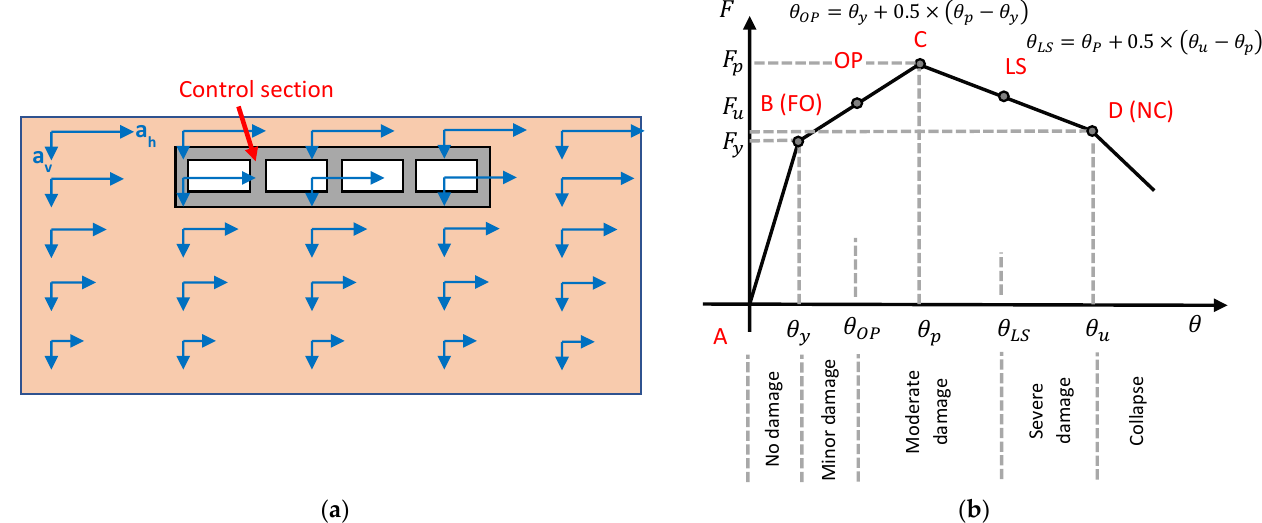
Figure 8. ( a ) Conceptual model for pushover analysis of an embedded structure and definition of control section for recording capacity, ( b ) thresholds of damage/performance states on shear force– drift capacity curve derived via pushover analysis ( θ y : drift ratio corresponding to yield point B, θ p : drift ratio corresponding to peak strength point C, θ u : drift ratio corresponding to ultimate strength point D defined at the moment when shear force drops to 85% of the peak force, θ OP : drift ratio threshold for performance state: OP, θ LS : drift ratio threshold for performance state: LS) (modified after He and Chen, [82]).